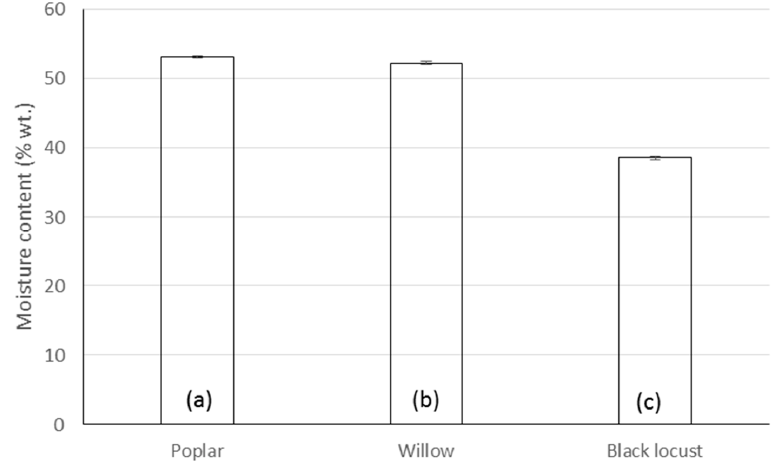
Figure 1. Mean values of moisture content. Means values with by a different letter are significantly different at p < 0.05. different at p <